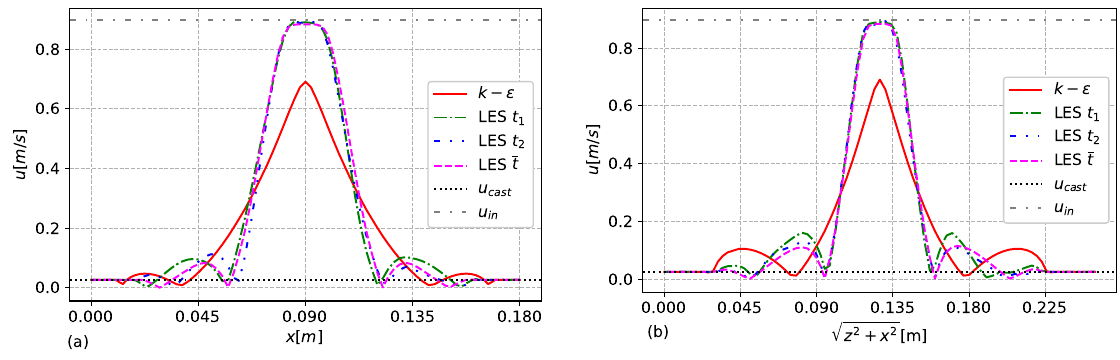
Figure 17. Velocity field. ( a ) at HL1; ( b ) at